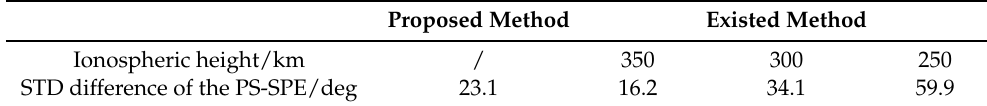
Table 3. Comparison with an Existed Method.